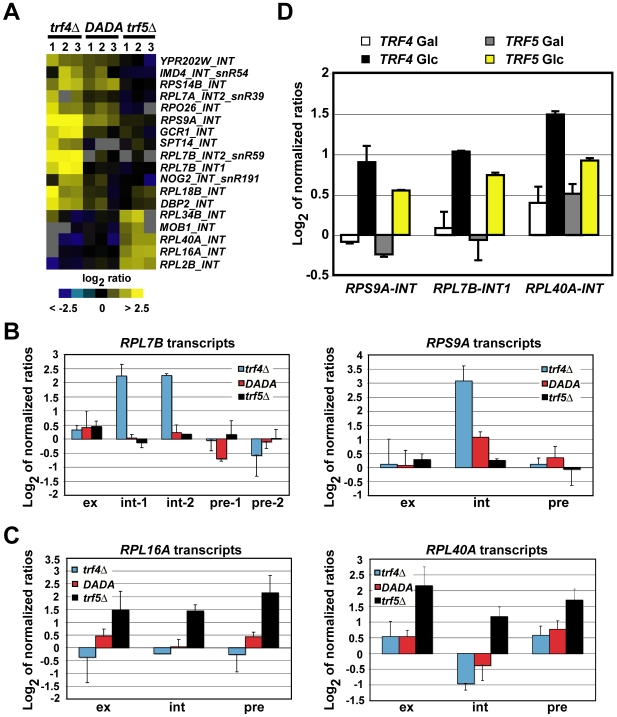
Trf4p promotes polyadenylation-independent degradation of introns.(A) Microarray data for 18 introns that changed more than 2-fold (FDRs<5%) in trf4Δ or trf5Δ mutants. Overexpression of Trf4p-DADA in trf4Δ mutant cells reduced steady-state levels of most of these introns to WT levels. Microarrays are the same as shown in Figure 1. Introns containing snoRNAs (snR) are indicated. (B) Relative changes of the expression of RPL7B (left panel) and RPS9A (right panel) introns, pre-mRNAs, and mature mRNAs as revealed by exon (ex), intron (int), and intron-exon junction probes (pre) present on the microarrays. Int-1 and int-2 refer to the first and the second intron of the RPL7B gene; pre-1 and pre-2 refer to the respective intron-exon junction probes of the RPL7B pre-mRNA. The height of the bar represents average log2 ratios from triplicate microarray data (Dataset S1); error bars show the standard deviation. (C) Relative changes of expression of RPL16A (left panel) and RPL40A (right panel) introns (int), pre-mRNAs (pre) and mature mRNAs (ex). Data was extracted from triplicate microarray data as described above. (D) Depletion of Trf4p or Trf5p promotes intron stability in vivo. Total RNA was purified from trf4Δ trf5Δ mutant strains either expressing TRF4 or TRF5, which were transcribed under the pGAL1 promoter. Cells were initially grown in a galactose containing medium (TRF4 Gal; TRF5 Gal) and then shifted to a glucose containing medium (YPD) at 30°C (TRF4 Glc; TRF5 Glc) for 1 h. Accumulation of introns of RPS9A and RPL40A and of the first intron of RPL7B was determined by qRT-PCR with intron-specific primers. The steady-state levels of introns in each sample was calculated as log2 of normalized ratios relative to the t0 time point, which corresponds to the cultures immediately before the galactose to glucose shift (for details see Materials and Methods). The values represent averages from two independent qRT–PCR analyses.